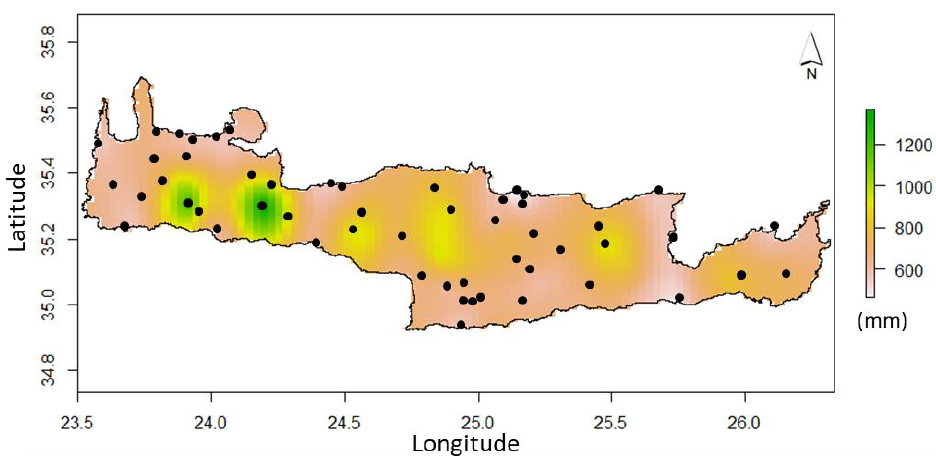
Figure 6. Spatial distribution of the estimated precipitation using STRK and the sum-metric space– time variogram model for the year 2016/17.